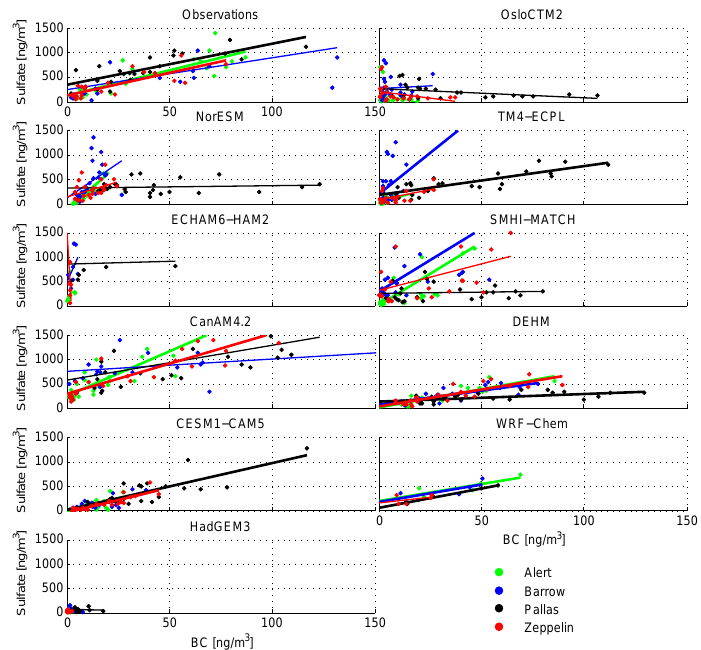
Figure 13. Correlation plots of monthly mean sulfate and (e)BC concentrations for the observations (top left) and the different models sampled at the observation sites. Thick lines denote significant